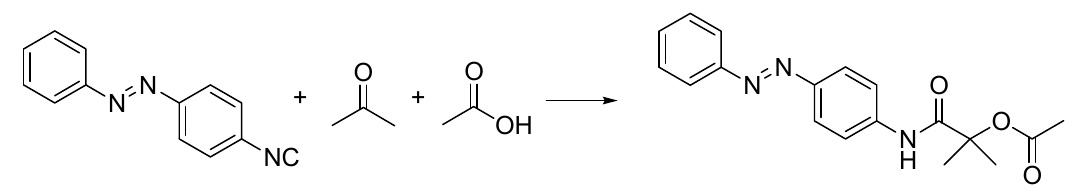
Scheme 20. The Passerini reaction